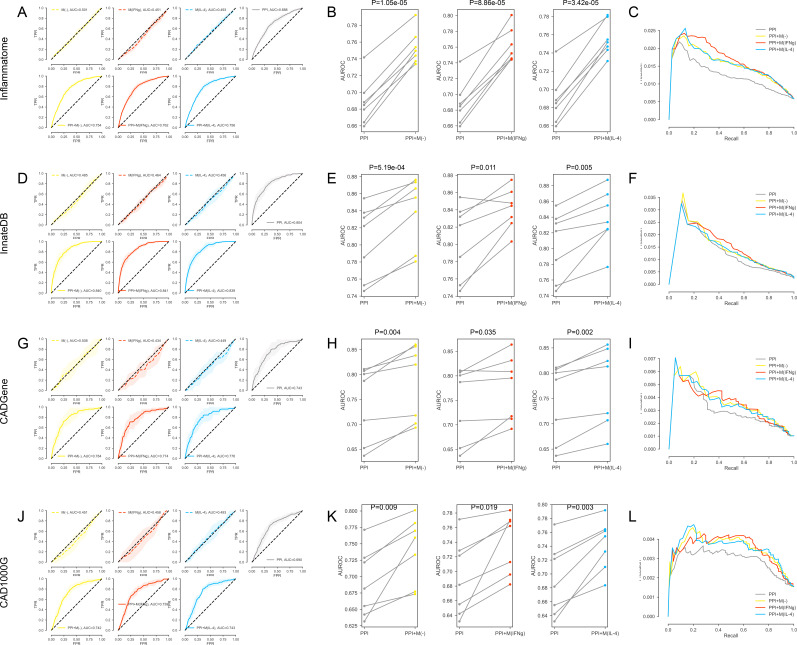
(A-C) For the inflammation (Inflammatome) signatures. (A) The k-fold cross-validated (k = 7) ROC curves for M(-), M(IFNγ), M(IL-4), PPI, PPI + M(-), PPI + M(IFNγ) and PPI + M(IL-4), respectively.Shaded regions represent the standard deviation of the AUROC values from all folds.(B) The AUROC values of each individual fold from the cross-validation for PPI and PPI + M(-), PPI and PPI + M(IFNγ), PPI and PPI + M(IL-4), respectively. Paired t-test was performed to obtain two-sided p-values. (C) Precision-recall curves for PPI, PPI + M(-), PPI + M(IFNγ) and PPI + M(IL-4). (D–F) For the innate immune response (InnateDB) signatures: (D) The k-fold cross-validated (k = 7) ROC curves for M(-), M(IFNγ), M(IL-4), PPI, PPI + M(-), PPI + M(IFNγ) and PPI + M(IL-4), respectively. Shaded regions represent the standard deviation of the AUROC values from all folds. (E) The AUROC values of each individual fold from the cross-validation for PPI and PPI + M(-), PPI and PPI + M(IFNγ), PPI and PPI + M(IL-4), respectively. Paired t-test was performed to obtain two-sided p-values. (F) Precision-recall curves for PPI, PPI + M(-), PPI + M(IFNγ) and PPI + M(IL-4). (G–I) For the coronary artery disease (CADGene) signatures: (G) The k-fold cross-validated (k = 7 for M(-) and M(IFNγ), k = 3 for M(IL-4)) ROC curves for M(-), M(IFNγ), M(IL-4), PPI, PPI + M(-), PPI + M(IFNγ) and PPI + M(IL-4), respectively. Shaded regions represent the standard deviation of the AUROC values from all folds. (H) The AUROC values of each individual fold from the cross-validation for PPI and PPI + M(-), PPI and PPI + M(IFNγ), PPI and PPI + M(IL-4), respectively. Paired t-test was performed to obtain two-sided p-values. (I) Precision-recall curves for PPI, PPI + M(-), PPI + M(IFNγ) and PPI + M(IL-4). (J–L) For the coronary artery disease (CAD1000G Extend) signatures: (J) The k-fold cross-validated (k = 7 for M(-) and M(IFNγ), k = 3 for M(IL-4)) ROC curves for M(-), M(IFNγ), M(IL-4), PPI, PPI + M(-), PPI + M(IFNγ) and PPI + M(IL-4), respectively. Shaded regions represent the standard deviation of the AUROC values from all folds. (K) The AUROC values of each individual fold from the cross-validation for PPI and PPI + M(-), PPI and PPI + M(IFNγ), PPI and PPI + M(IL-4), respectively. Paired t-test was performed to obtain two-sided p-values. (L) Precision-recall curves for PPI, PPI + M(-), PPI + M(IFNγ) and PPI + M(IL-4).